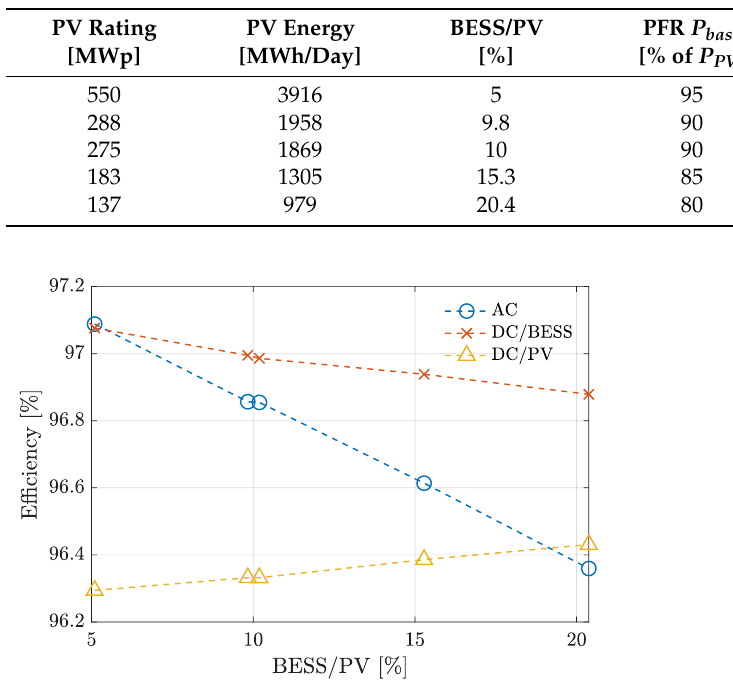
Figure 13. Layout efficiency as a function of the BESS/PV daily energy ratio.